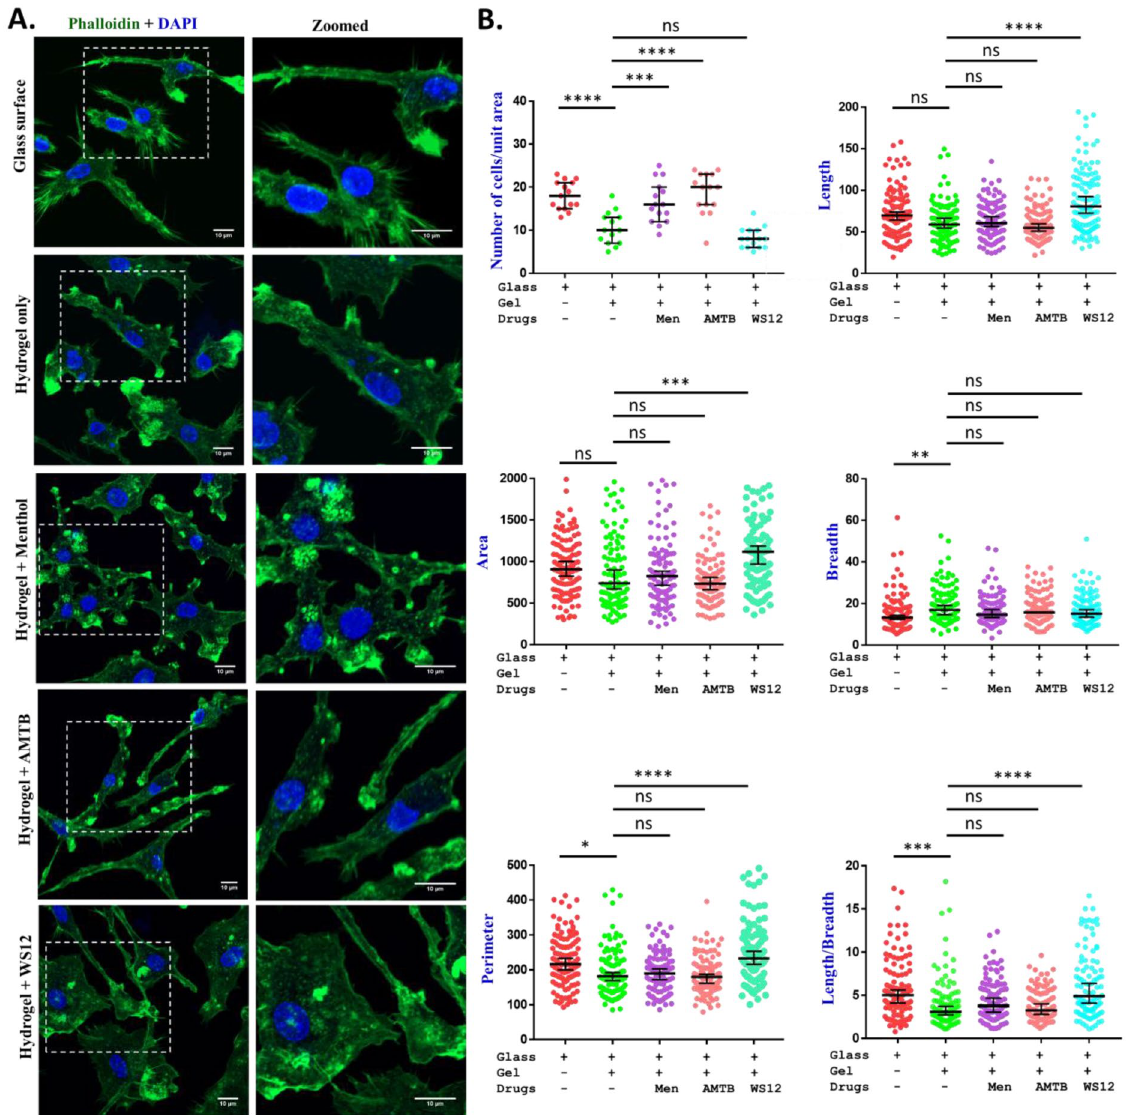
Figure 4. Hydrogel-mediated drug release alters the morphology of bone marrow derived mesenchymal stem cell population. BM-MSCPs were isolated and grown on only glass, only hydrogel or on hydrogel-coated with different drugs affecting TRPM8 ion channel. (A) Morphology of cells grown on different surface are shown. Cells were stained with Phalloidin (green) and DAPI (blue). (B) Different morphology parameters of the cells grown on different surface are shown. The statistical values are: ANOVA test, p values: * < 0.05, ** < 0.01, *** < 0.001, **** <